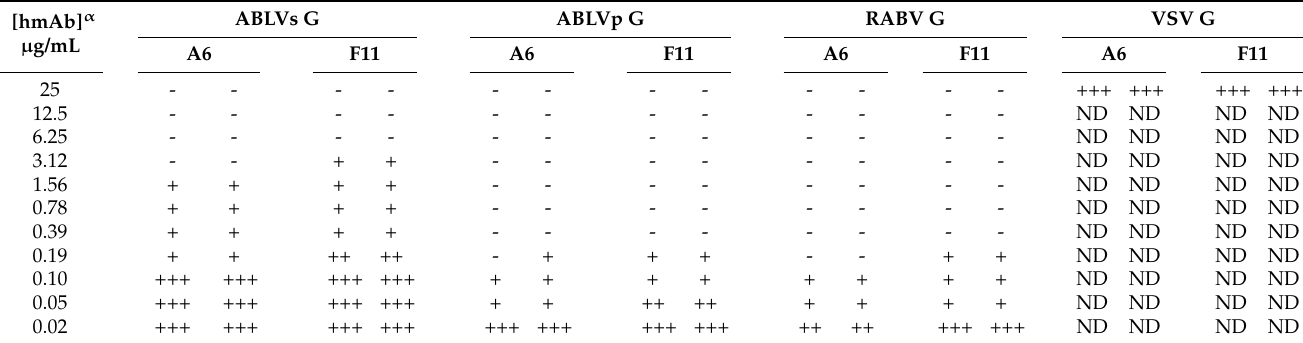
(Figure 4A). Conversely, greater than 50% inhibition of rVSV-ABLVp-G (Figure 4B) and rVSV-RABV-G (Figure 4C) infections was achieved by treatment with 0.05 µ g/mL A6 or F11. Furthermore, as detailed in Table 2, A6 neutralized 100% of recombinant rVSV- ∆ G reporter viruses expressing ABLVs G (3.12 µ g/mL), ABLVp G (0.39 µ g/mL), and RABV G (0.19 µ g/mL) at lower concentrations than those observed for F11 (6.25, 0.39, and 0.39 µ g/mL respectively). Taken together, these results demonstrate that hmAbs A6 and F11 are potent cross-reactive antibodies that can neutralize both known ABLV variants as well as RABV CVS variant, another phylogroup I virus. Table 2. Neutralization of rVSV-GFP infection by hmAbs A6 and F11.